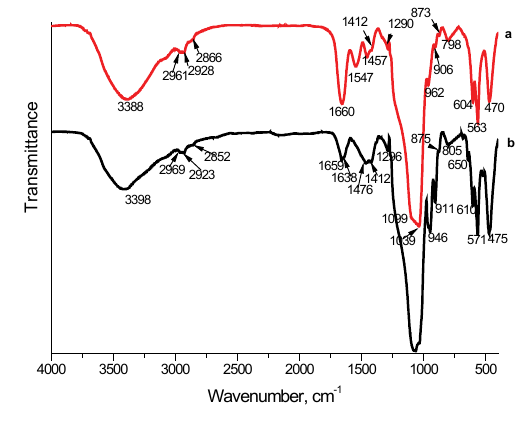
Figure 3. FTIR of the prepared hybrids in different amount of the components - 75G:25CPS/W, wt. % (a) and 25G:75CPS/W, wt. % (b) after immersion in 1.5 SBF for 3